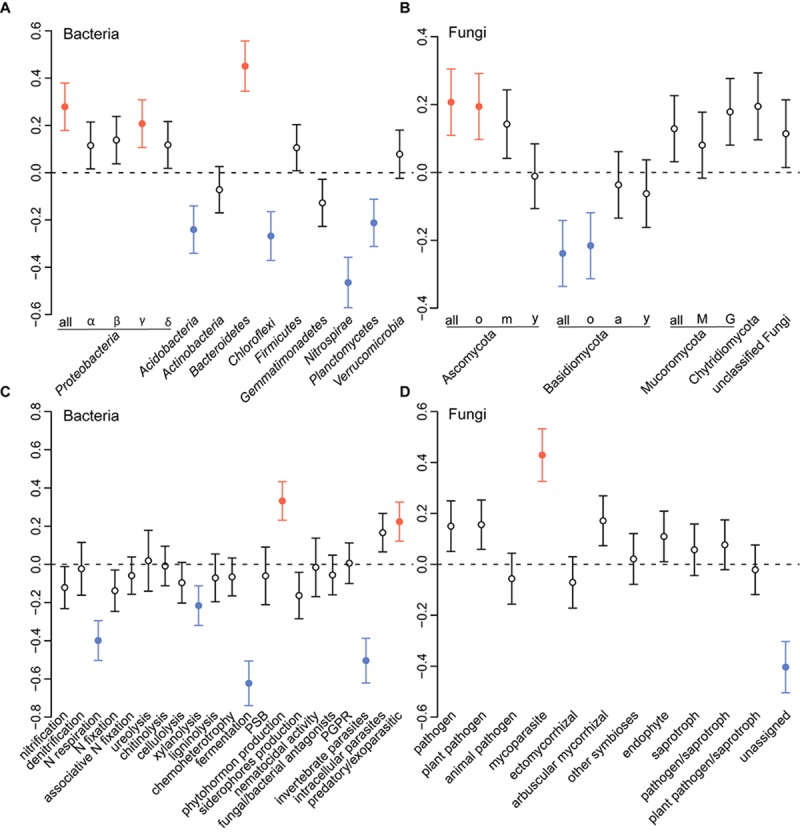
Posterior mean (with standard deviation) estimates of standardized coefficients (dimensionless) showing the variation in bacterial (A,C) and fungal (B,D) phyla and functional group OTU abundance between the rhizosphere and bulk soil. Red or blue colors indicate strong positive or negative responses of microbial relative abundance to the rhizosphere soil tested with generalized attribute modeling (gjam). (A,B) All, entire OTU abundance of a phyla; o, other Ascomycota and Basidiomycota species; m, ascomycetes mold fungi; y, ascomycetes and basidiomycetes yeast species; a, agaricoid basidiomycetes; M, Mortierellomycotina; G, Glomeromycotina subphyla of Mucoromycota. (C) PSB, phosphate solubilizing bacteria; PGPR, plant growth promoting rhizobacteria.